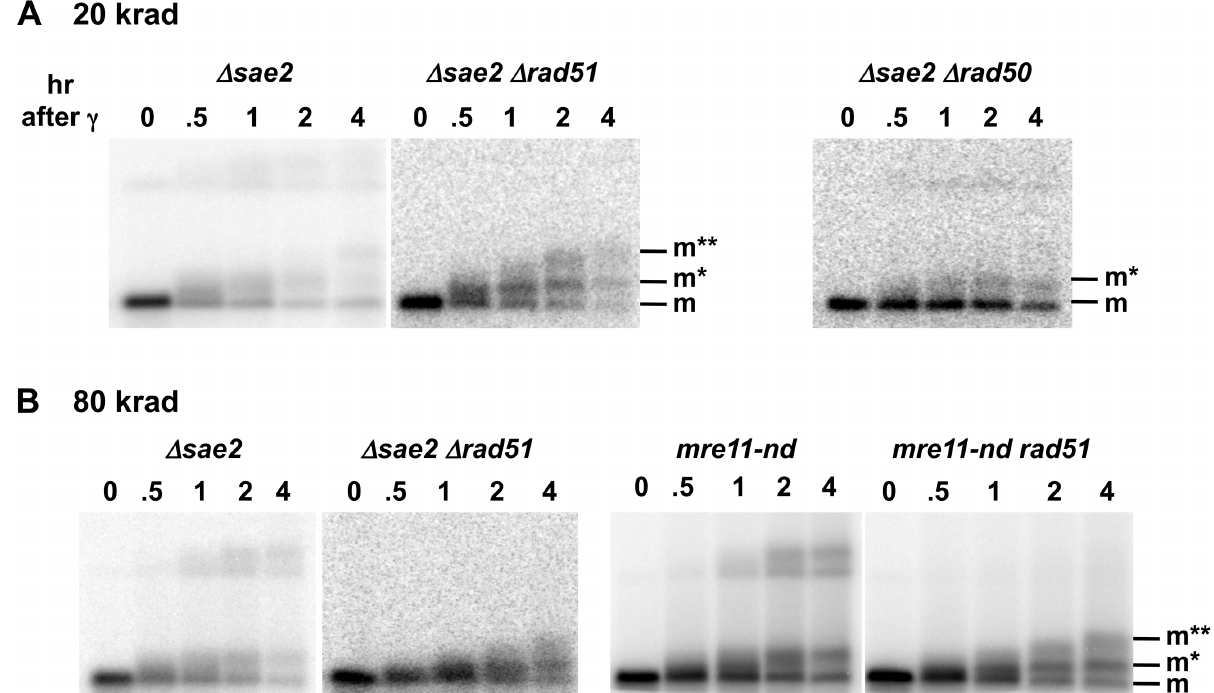
Figure 4. Sae2 and Mre11-nuclease are required for coincident resection, DSB repair, and high survival following IR of G2 arrested cells. Compared to the single mutant D sae2 , there is an increase in 1-end resected molecules and the appearance of 2-end resected molecules after IR treatment of the double mutant D sae2 D rad51 , which lacks the strand invasion step in HDRR. (The reduction in signal at 4 hr for D sae2 D rad51 in 3A is due to less DNA on the gel.) Thus, the loss of material at late times for D sae2 (Figure 1A and 1B) is likely due to HDRR. The response of the nuclease-defective mre11-nd and mre11-nd D rad51 strains (in 4B) is comparable to the D sae2 and D sae2 D rad51 mutants. The two upper bands seen in the D sae2 and mre11-nd single mutants correspond to unresected and resected forms of recombination dependent dimer molecules indicated as d and d* in Figure 1B and 1C. (Note: the D sae2 image in 4B is the same as in 1B and is presented here for comparison.) A. 20 krad. B. 80 krad.